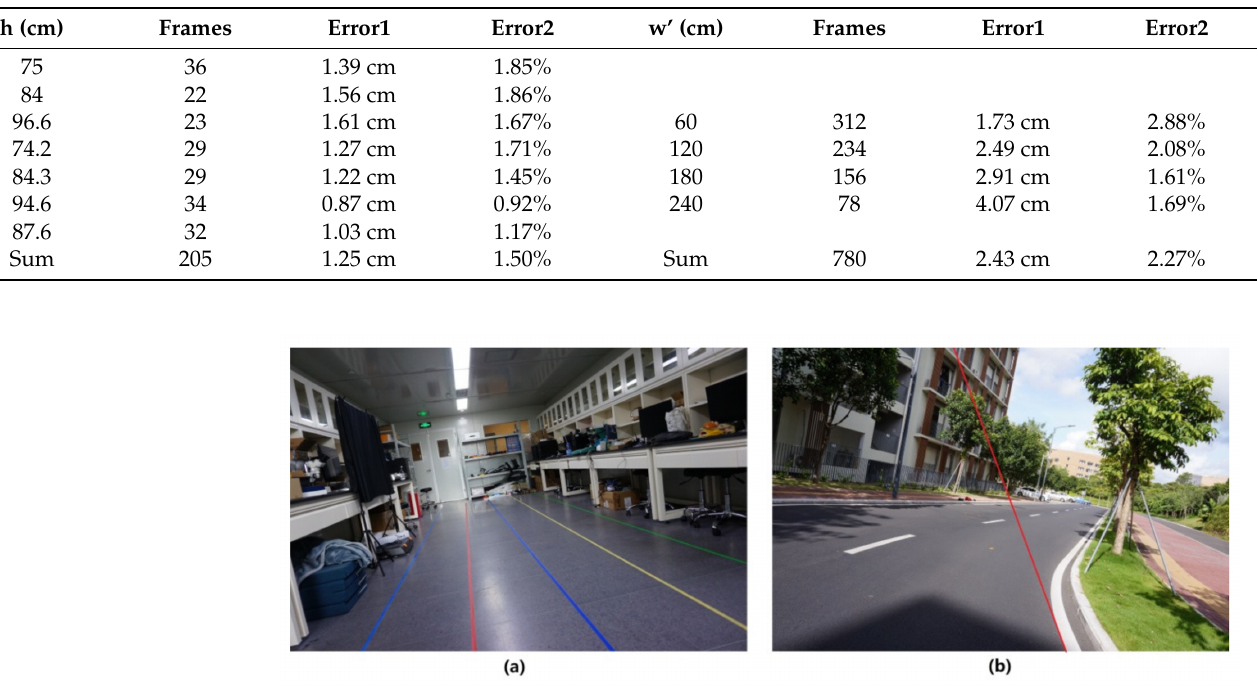
Table 4. The experimental results of camera height h and lane-width w’. (Error1 is error in cm and Error2 is error in percentage).